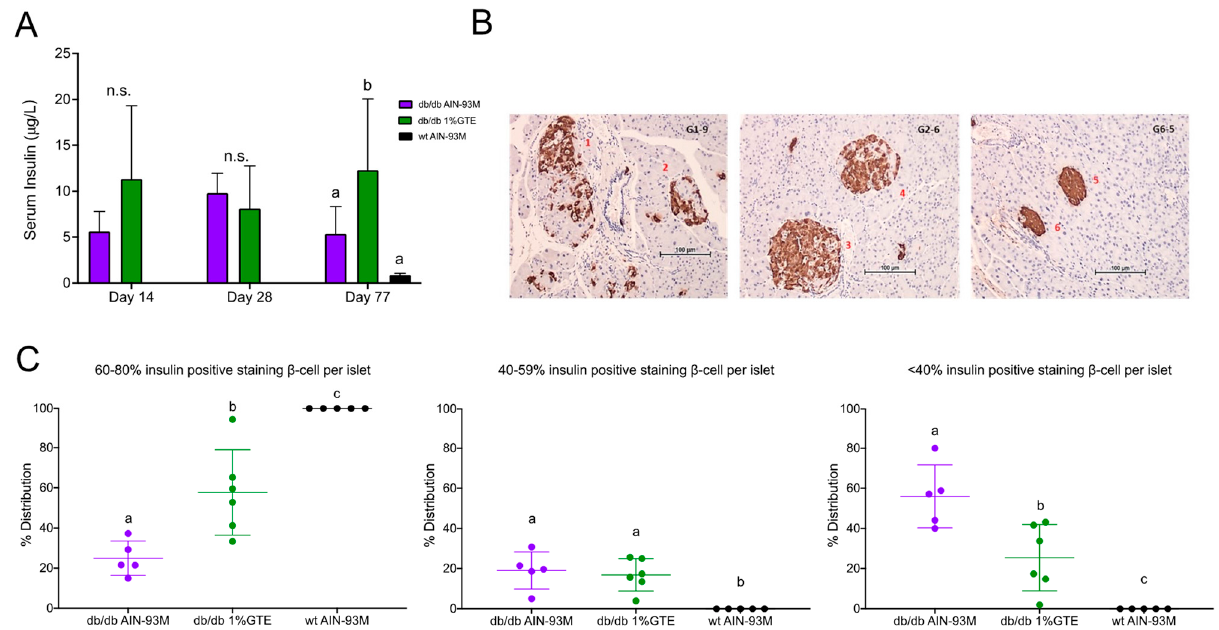
Figure 2. Fasting serum insulin levels and insulin immunostaining in db/db mice fed control or 1% GTE diet and the wildtype mice. ( A ) Fasting serum insulin levels on Days 14, 28, and 77. ( B ) IHC staining for insulin (brown color) in pan- creatic β –cells in mice harvested on Day 77; from left to right, db/db AIN–93M, db/db 1% GTE, and wildtype AIN–93M. ( C ) Distribution of percent positive IHC staining cells. Data points not sharing common compact letters were significantly different from each other ( p < 0.05).